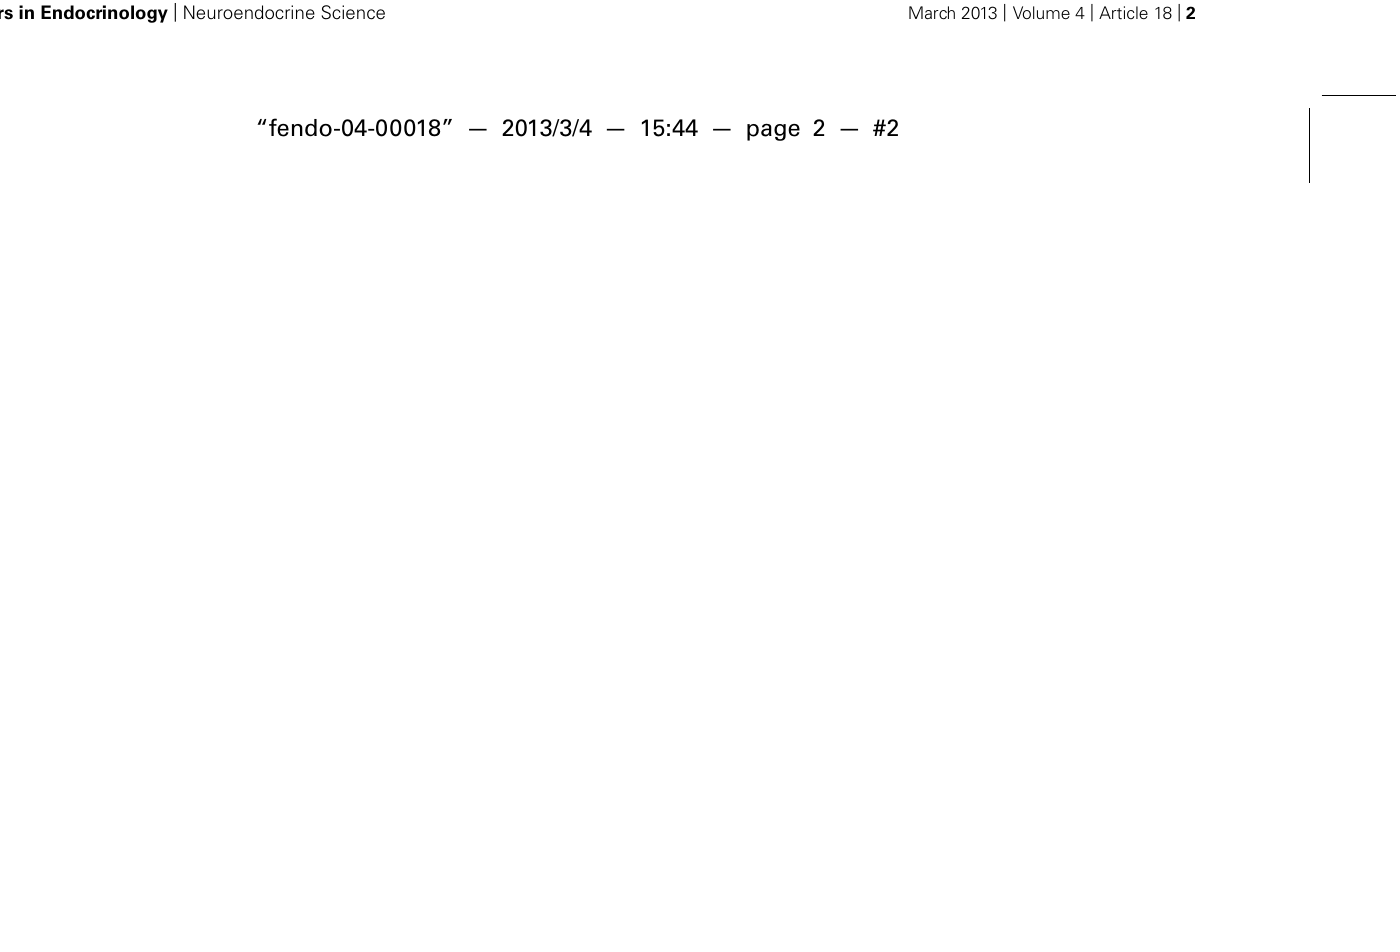
Abbreviations: Arc, arcuate nucleus; DR, dorsal raphe nucleus; LC, locus coeruleus; LDT, laterodorsal tegmental nucleus; PPT, pedunculopontine tegmental nucleus;TMN, tuberomammillary nucleus;VTA, ventral tegmental area;VLPO, ventrolateral preoptic